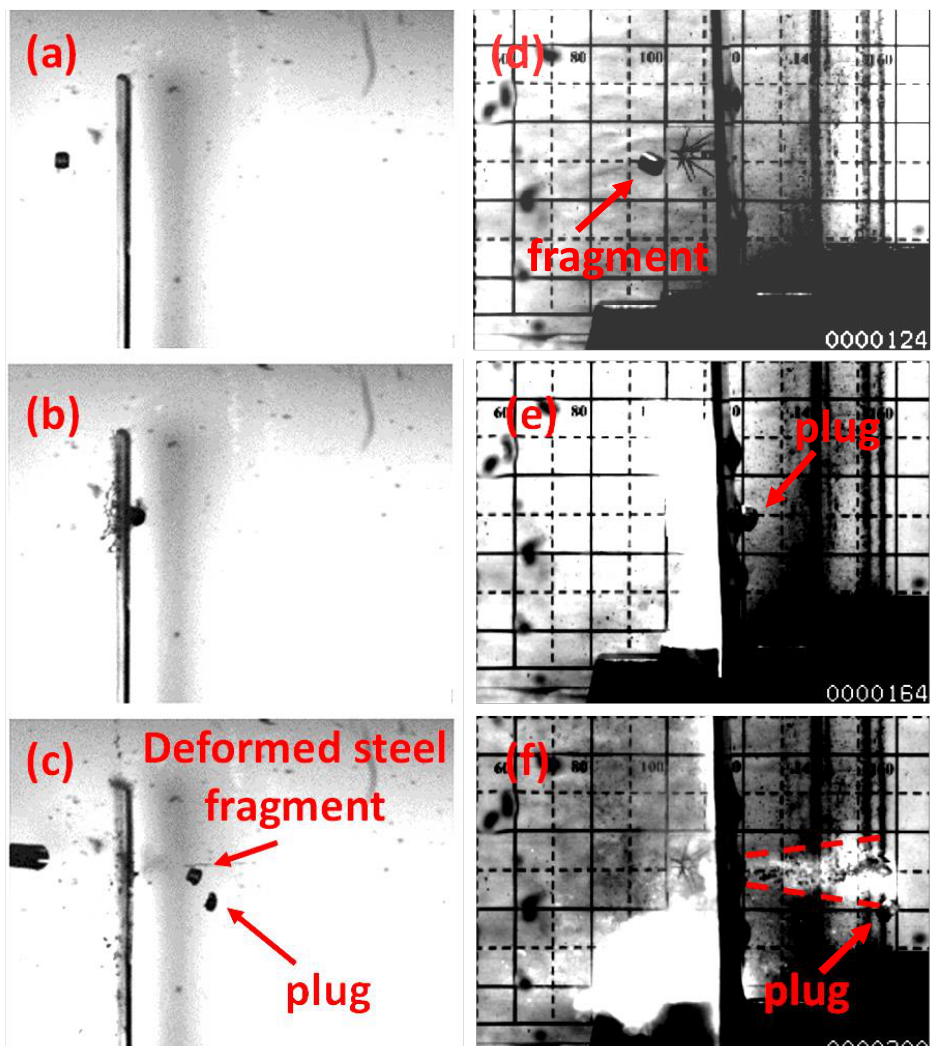
Figure 9. Failure mode comparison. On the left, 4.6 mm steel fragment impacting 2 mm plate at 693 m/s; on the right, 5 mm MREs fragment impacting 2 mm plate at 877 m/s. ( a ) steel fragment flying towards the target, ( b ) impact between steel fragment and the plate, ( c ) the deformed fragment perforates the target and the plug is ejected; ( d ) MRE fragment flying towards the target with 24 degrees of yaw, ( e ) impact, pre-perforation energy release and plug formation, ( f ) the fragment shatters during the interaction with the target and spreads behind the